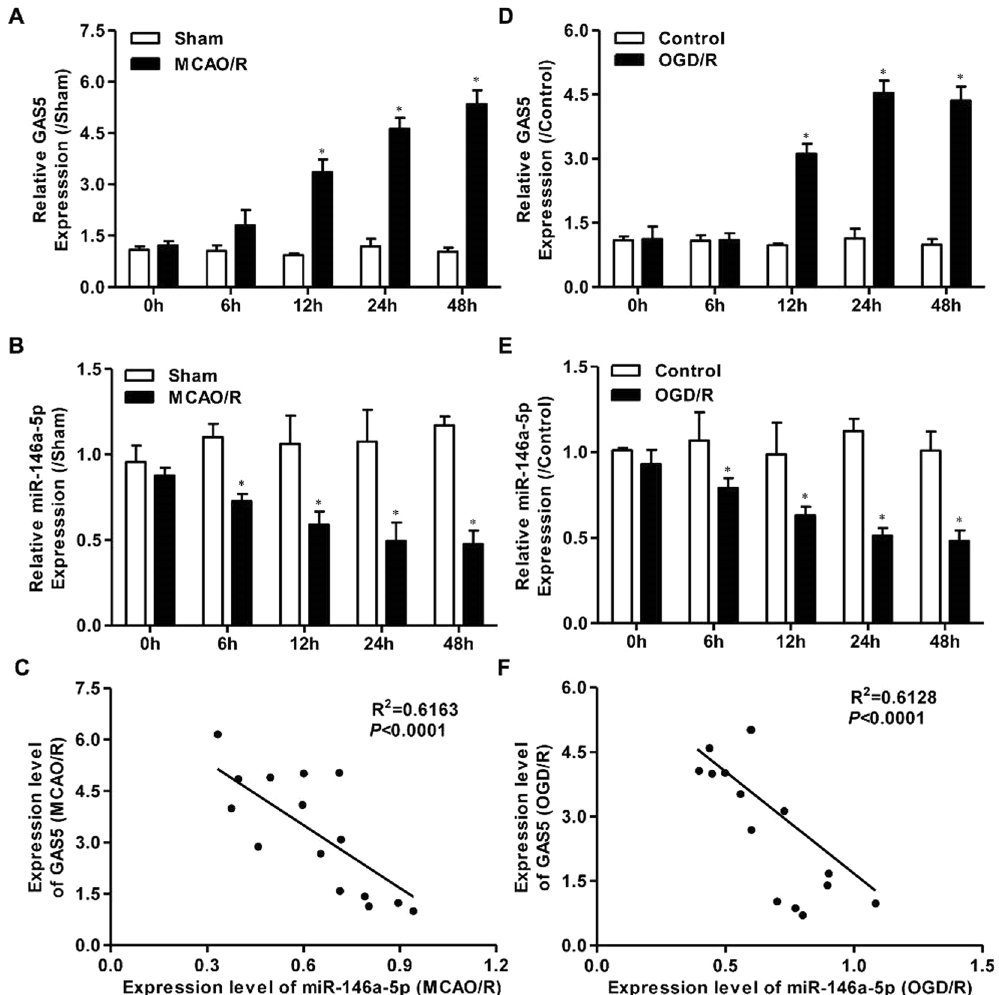
Figure 4. GAS5 up-regulation is involved in miR-146a-5p down-regulation both in vivo and in vitro models of ischemic stroke. RT-PCR assay for the expression of GAS5 ( A ) and miR-146a-5p ( B ) at each time point in mice subjected to 1 h MCAO and at 0 h, 6 h, 12 h, 24 h, and 48 h of reperfusion (n = 3 per group). RT-PCR was used to detect the expression of GAS5 ( D ) and miR-146a-5p ( E ) in cultured BV2 microglia cells at each time point in BV2 microglial cells subjected to 4 h OGD and at 0 h, 6 h, 12 h, 24 h, and 48 h of reperfusion (n = 3 per group). ( C ) Pearson’s correlation analysis of the relationship between GAS5 and miR-146a-5p in the brain of mice subjected to MCAO/R surgery. ( F ) Pearson’s correlation analysis of the relationship between GAS5 and miR- 146a-5p in BV2 microglial cells subjected to OGD/R treatment. Data are represented as mean ± SD, * P <